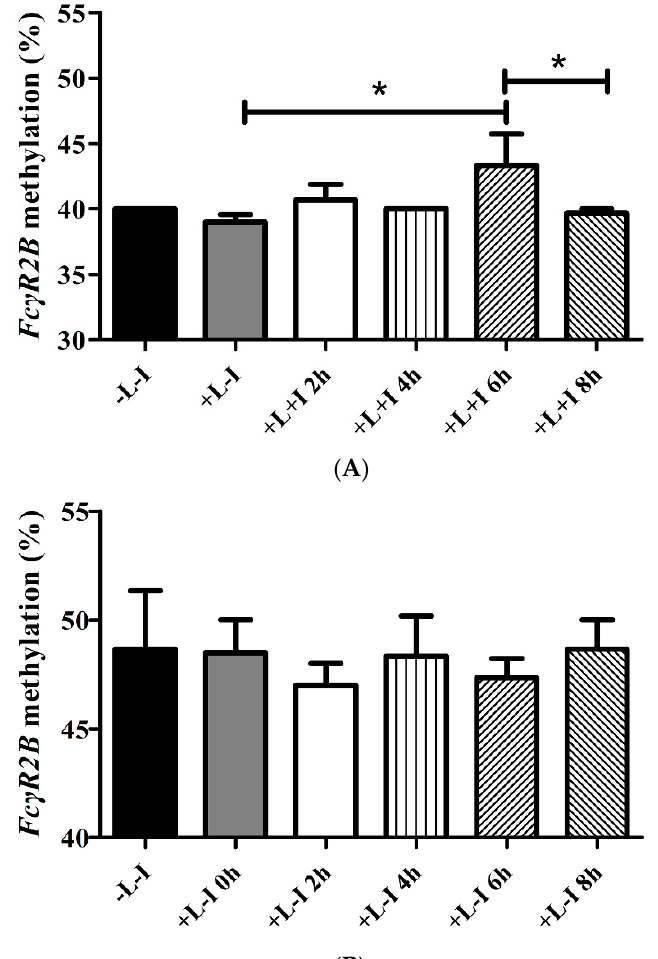
Figure 6. ( A ) At 6 h, upregulated Fc γ R2B methylation was detected, compared with THP-1 cells without IVIG supplement. IVIG significantly increased the Fc γ R2B methylation in the LPS-treated THP-1 cells. ( B ) No change was detectable in THP-1 cells pretreated only with lipopolysaccharide at different time points. H, hours; I, intravenous immunoglobulin; L/LPS, lipopolysaccharide (* p < 0.05).